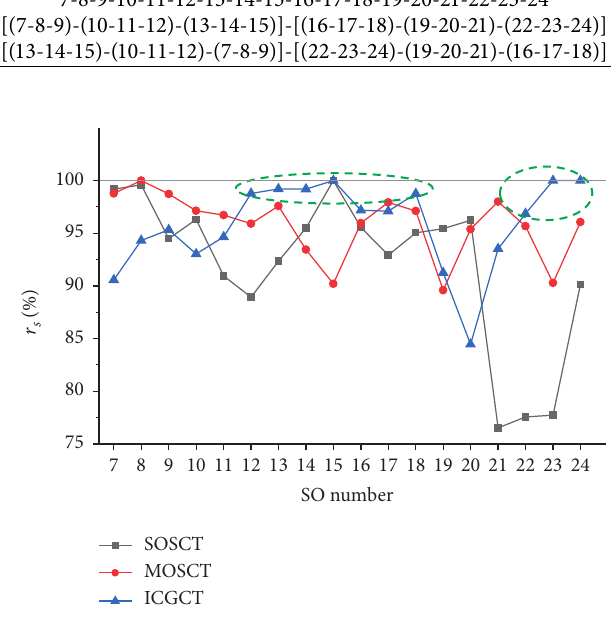
Figure 7: The change of r s under three caving